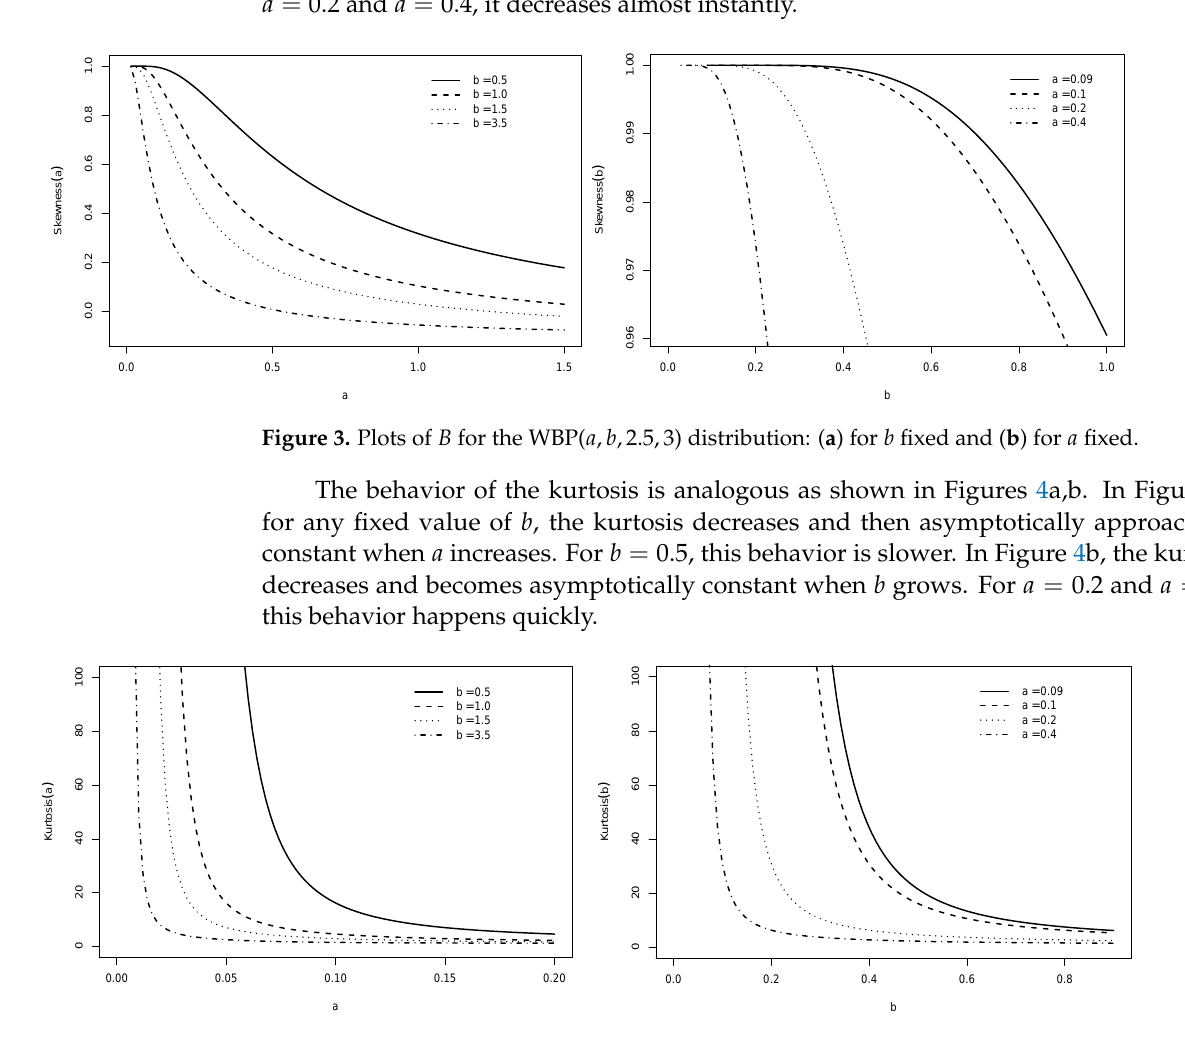
Figure 4. Plots of M for the WBP( a , b ,2.5,3) distribution: ( a ) for b fixed and ( b ) for a